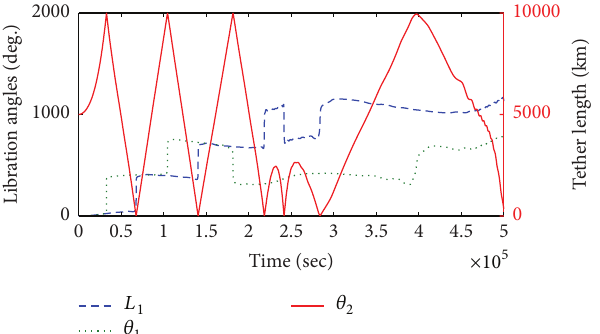
Figure 10: Libration angles and tether length 𝐿 1 by the formulations based on point 𝐴 for a prescribed function 𝐿 1 (𝑡) .